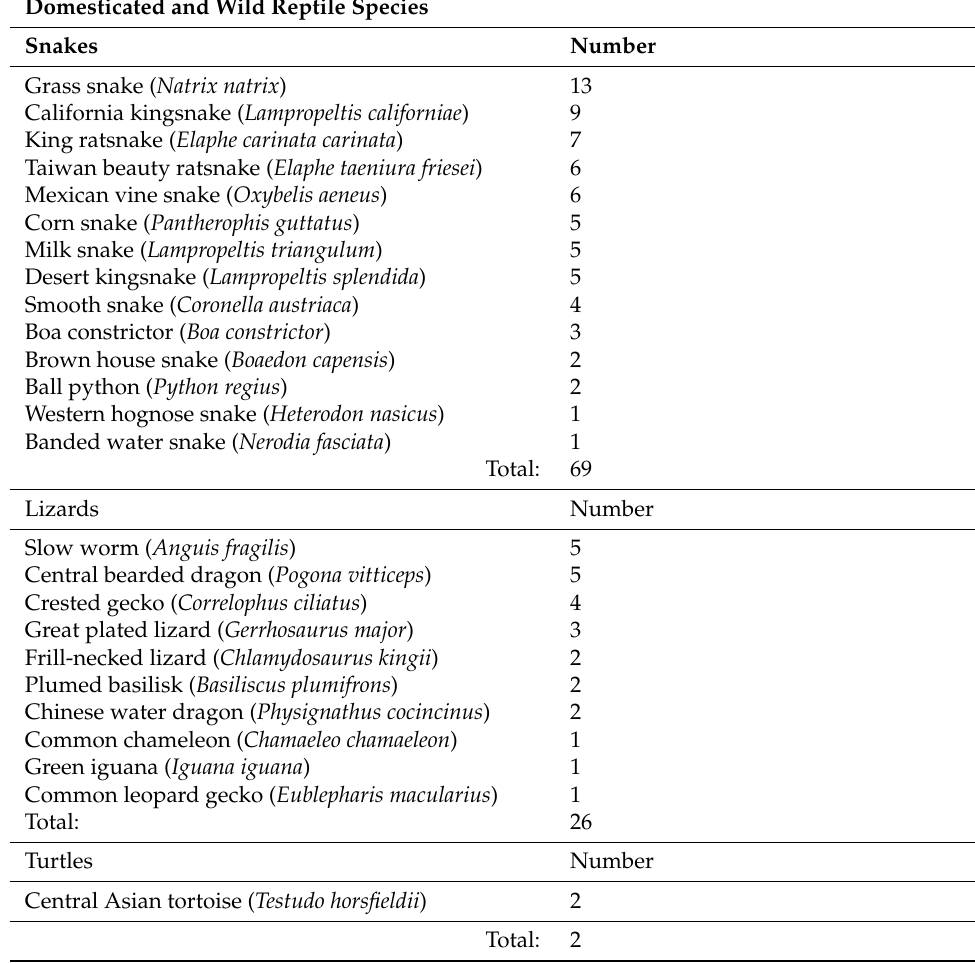
Table 1. Species and number of tested